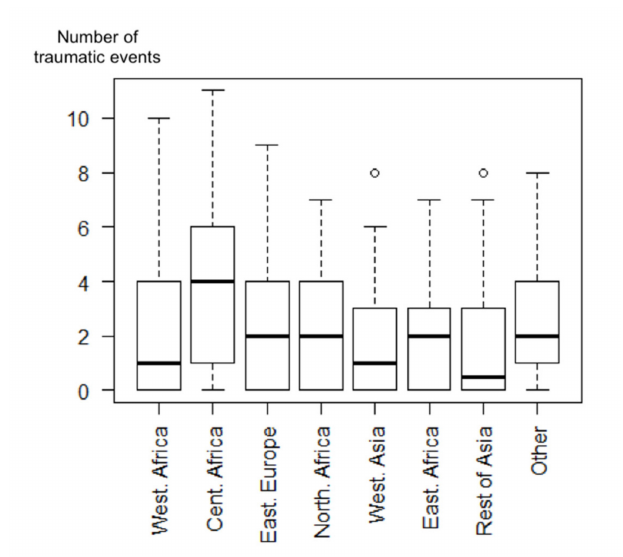
Figure 2. Boxplot representing the number of traumatic lifetime events according to the country of origin among migrant homeless mothers in the Paris region (ENFAMS survey 2013, n = 691). Table 2. Traumatic lifetime events in homeless migrant mothers who su ff ered from Post-traumatic stress disorder (PTSD) in the last 12 months, Paris region (ENFAMS survey 2013, n = 120). Traumatic Lifetime Events Women with PTSD ( n = 149) % Unexpected or sudden death of an intimate friend or a member of family